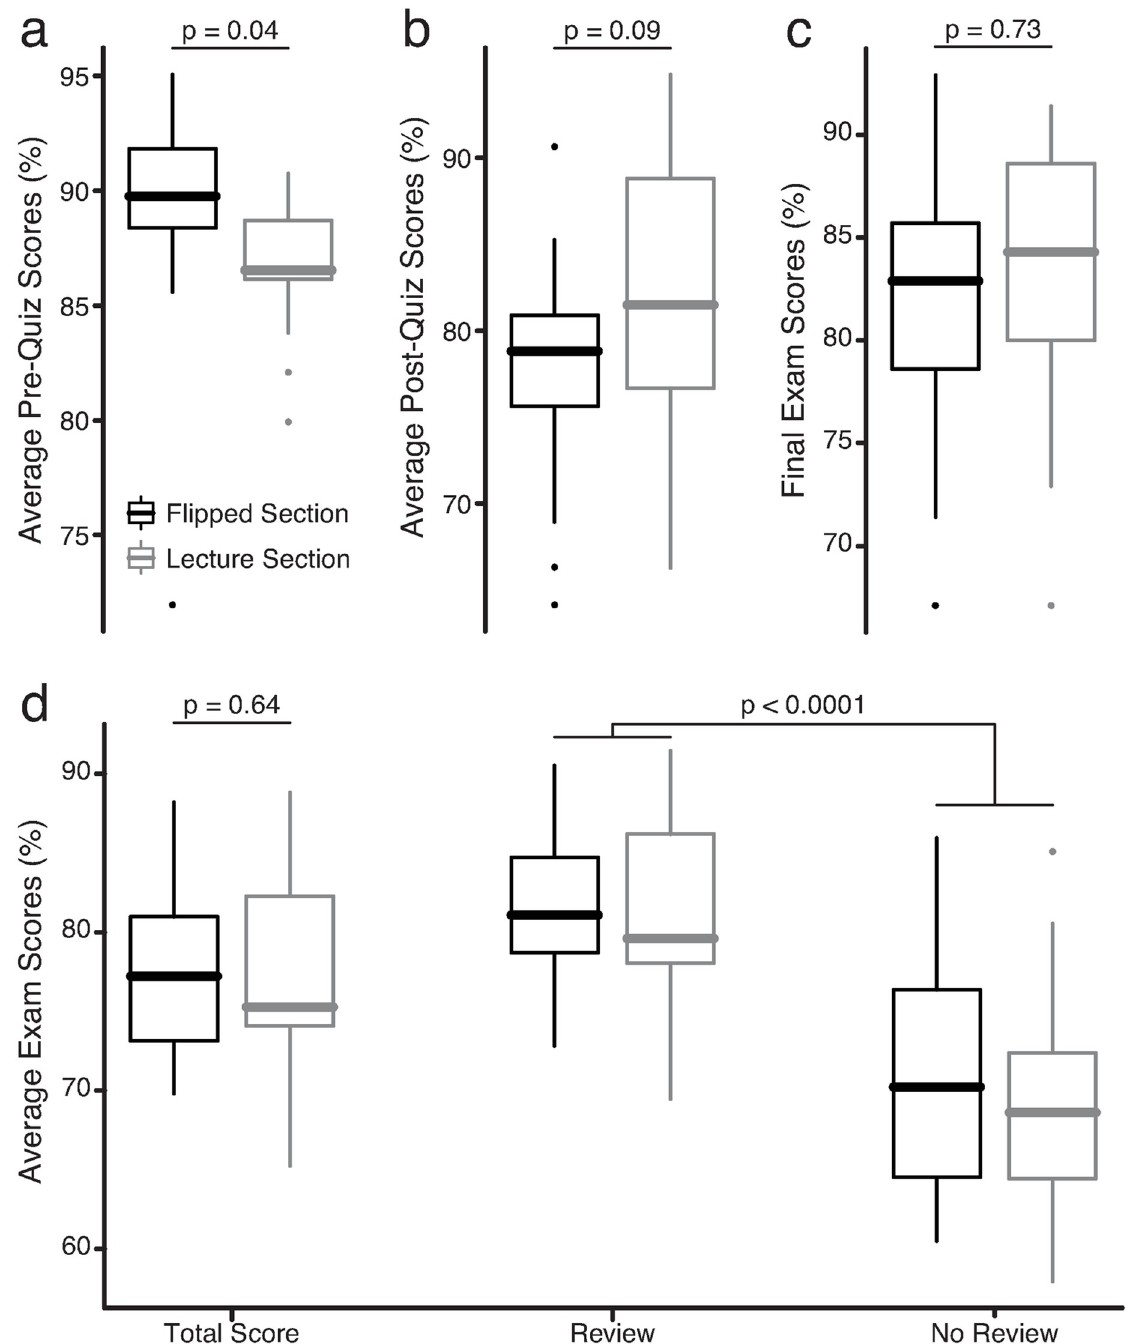
Fig 3. Performance on quizzes and exams. (a) Pre-quiz scores were higher in the flipped section (black) than the lecture section (gray). Pre- quizzes were prospective for the lecture section and retrospective for the flipped section. No significant differences were found between scores in the flipped and lecture sections on post-quizzes (b) or the final exam (c). (d) Total exam scores were similar in the flipped and lecture sections. Scores on exam items that were based on review or quiz questions (Review) were significantly higher than scores on novel exam questions (No Review). This effect was consistent in the flipped and lecture sections. P-values were obtained from Welch’s t-tests.